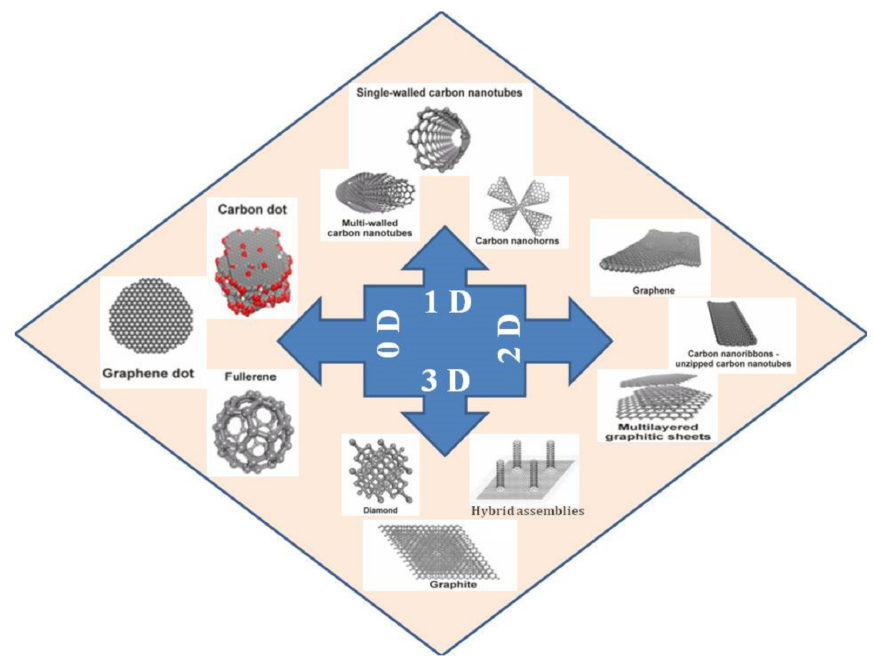
Figure 3. Allotropes of carbon nanomaterials ranging from 0D to 1D, 2D, and